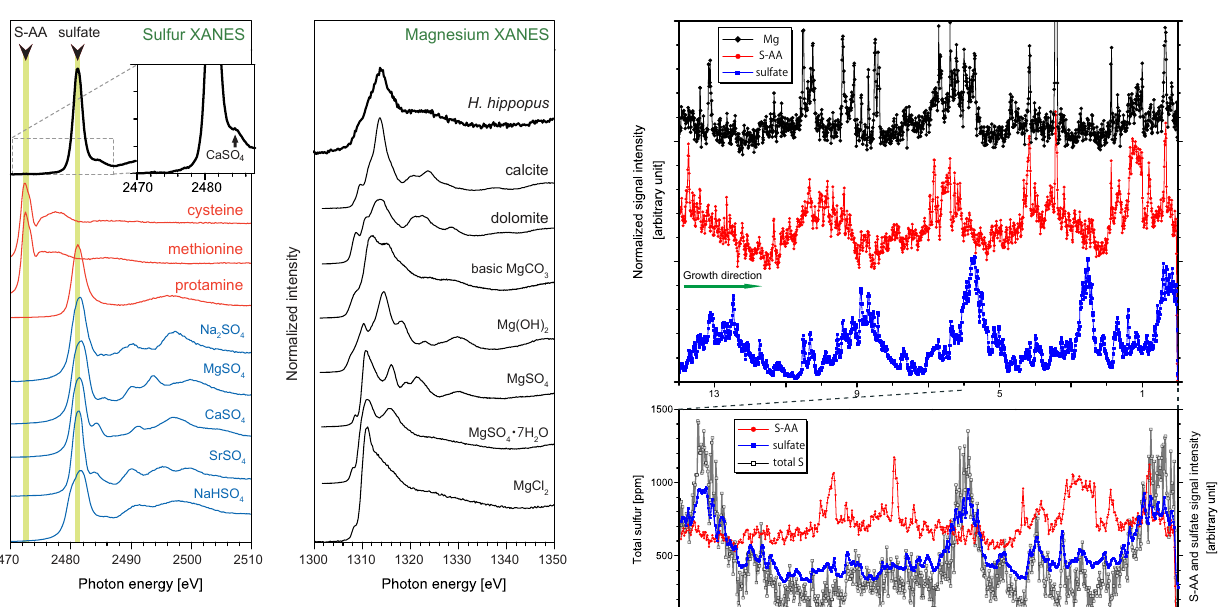
Figure 2. S (left) and Mg (right) K -edge XANES spectra of a giant clam shell aragonite ( H. hippopus ) and reference materials. Micro- XANES of marine clamshell aragonite ( H. hippopus ) performed at focused mode on points at S maxima. The XANES spectra have been published previously (Yoshimura et al., 2013a, b). The µ - XRF/XAS measurements were made at a fixed excitation energy based on the characteristic resonance peak energies of S-bearing amino acids (2473eV) and sulfate (2482eV).